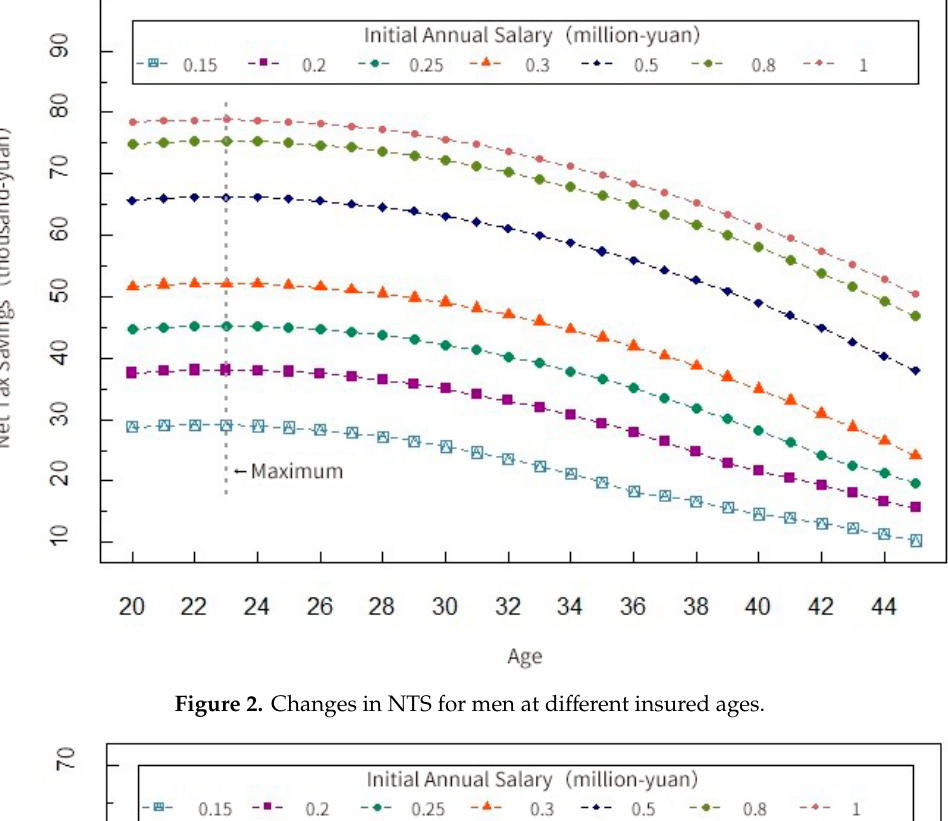
Figure 2. Changes in NTS for men at different insured ages.